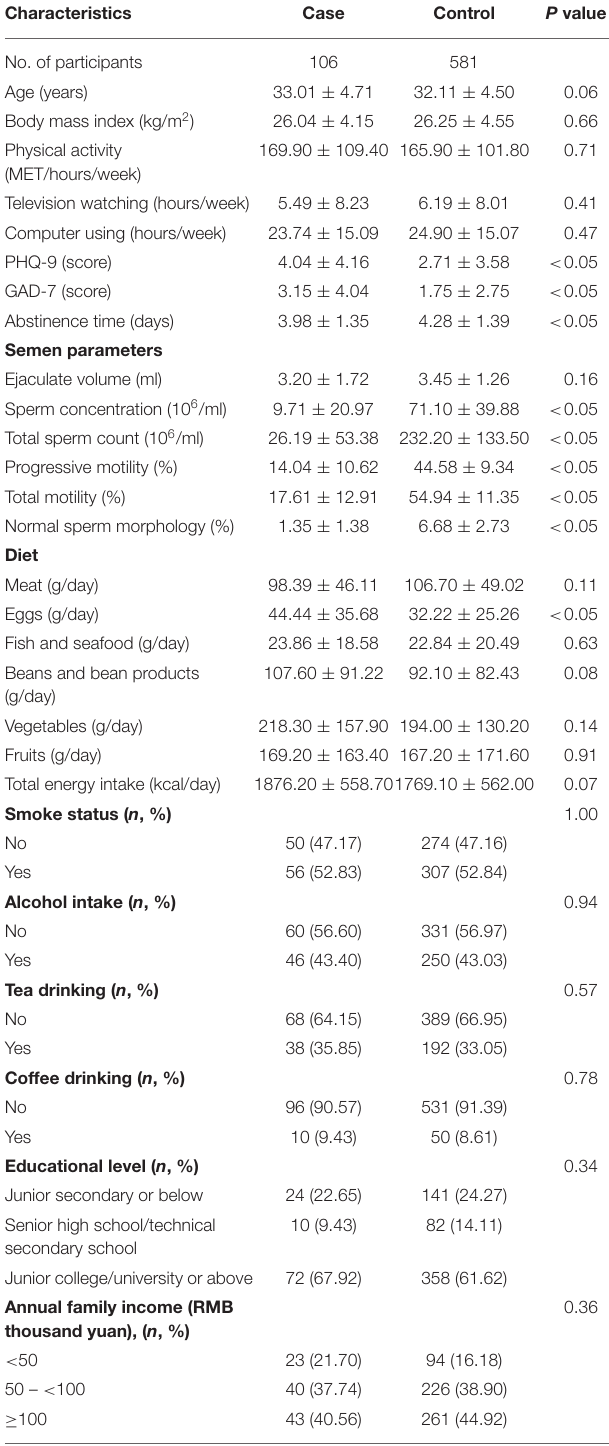
TABLE 1 | General characteristics of participants in a case-control study of oligo-astheno-teratozoospermia.